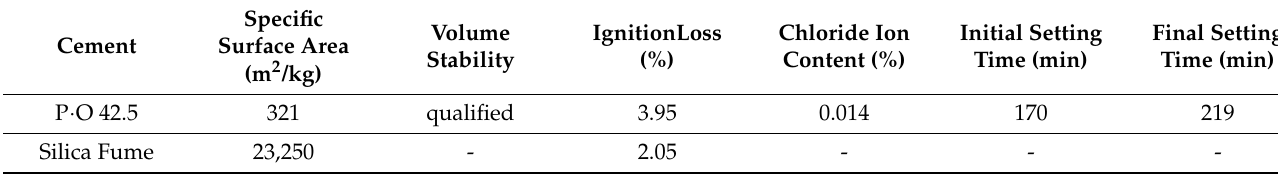
Table 1. Main properties of cement and silica